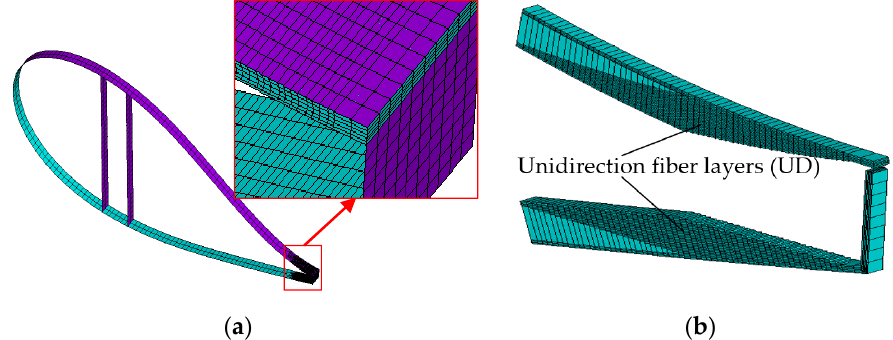
Figure 4. A cross-sectional view of the FEM model of the blade: ( a ) Local details of the trailing edge with the shell element; ( b ) Local details of the trailing edge without the adhesive, and bonding flange and shell element are shown with rendered thickness.